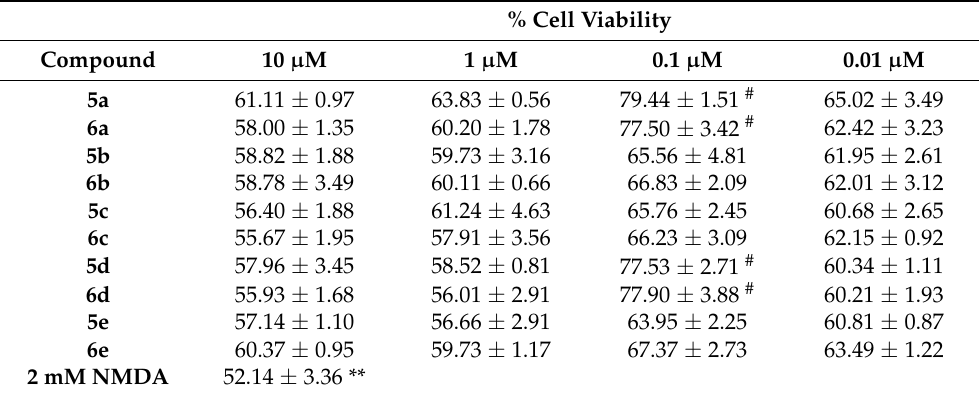
Table 2. Cell viability results following treatment with triazolo-tomentosin derivatives against NMDAR-mediated excitotoxicity, p < 0.05 significant difference from NMDA-treated